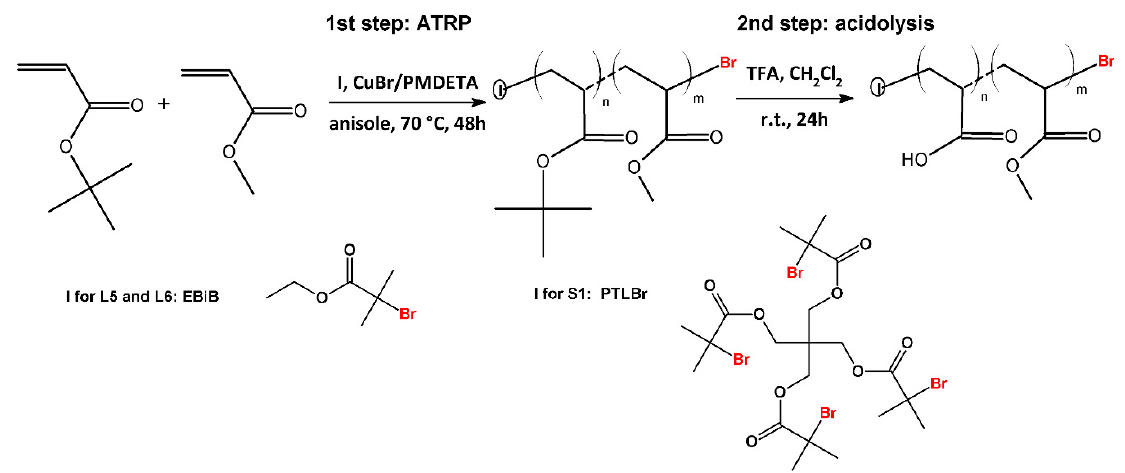
Table 2. Characterization of linear and star-shaped P(AA- co -MA) samples obtained via atom transfer radical polymerization (ATRP) and subsequent acidolysis.